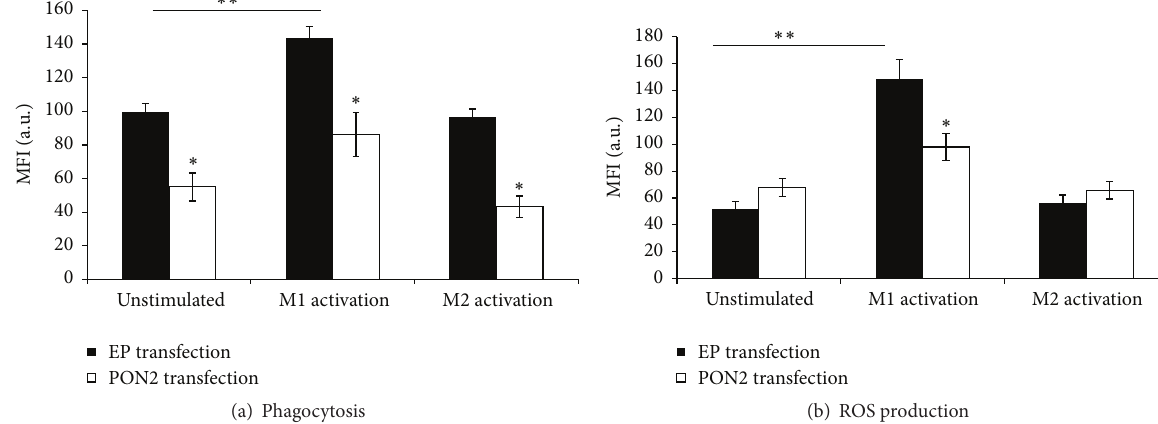
Figure 5: Direct effect of hPON2 on M1 functional phenotype in PON2KO MPM. MPM obtained from 3-month-old PON2KO male mice were transfected with pcDNA3.1+ empty plasmid (EP) or with pcDNA3.1+ plasmid containing hPON2 for 4 hours at 37 ∘ C. Cells were then washed and cultured with DMEM medium + 10% fetal calf serum for 48 hours. The cells were cultured for an additional 12 hours either unstimulated or stimulated with IFN 𝛾 /LPS or IL-4. (a) Phagocytosis was determined in cells that were incubated with FITC-conjugated latex beads for an additional 4 hours and analyzed using FACS. Results are given as mean fluorescence intensity (MFI). (b) ROS production was measured after 45 minutes of incubation with DCFH by FACS and is expressed as MFI. Results are expressed as mean ± SD ( 𝑛 = 3 ), ∗ 𝑃 < 0.01 , PON2KO MPM versus control MPM; ∗∗ 𝑃 < 0.01 , M1 stimulated versus unstimulated